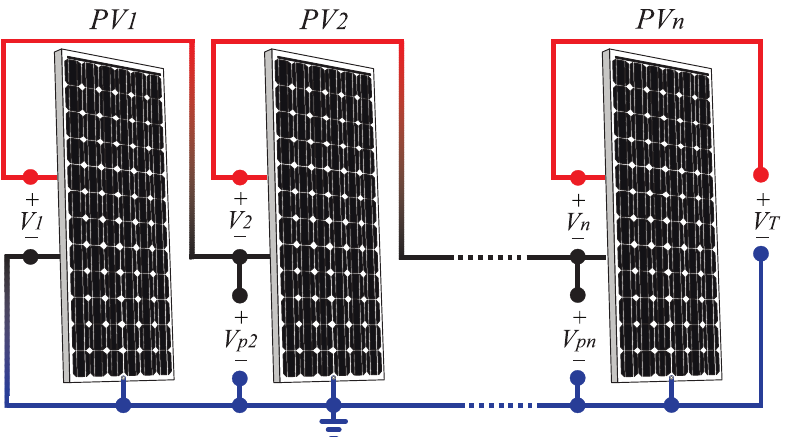
Figure 3. A string of photovoltaic modules (PVMs). Since the PVMs’ frames are connected to the ground of the output voltage V T (blue wires), there are potentials V p 2 , . . ., V pn between negative poles (gray wires) of PV 2 , ..., PV n and the ground. The highest frame potential is V pn and can be high enough to create a parasitic current flowing through the front glass and encapsulation of the PVM, degrading their solar cells. Although PV n is more predisposed to suffer this degradation because the potential is major, it can occur in any module from PV 1 to PV n . Many authors know this degradation phenomenon as